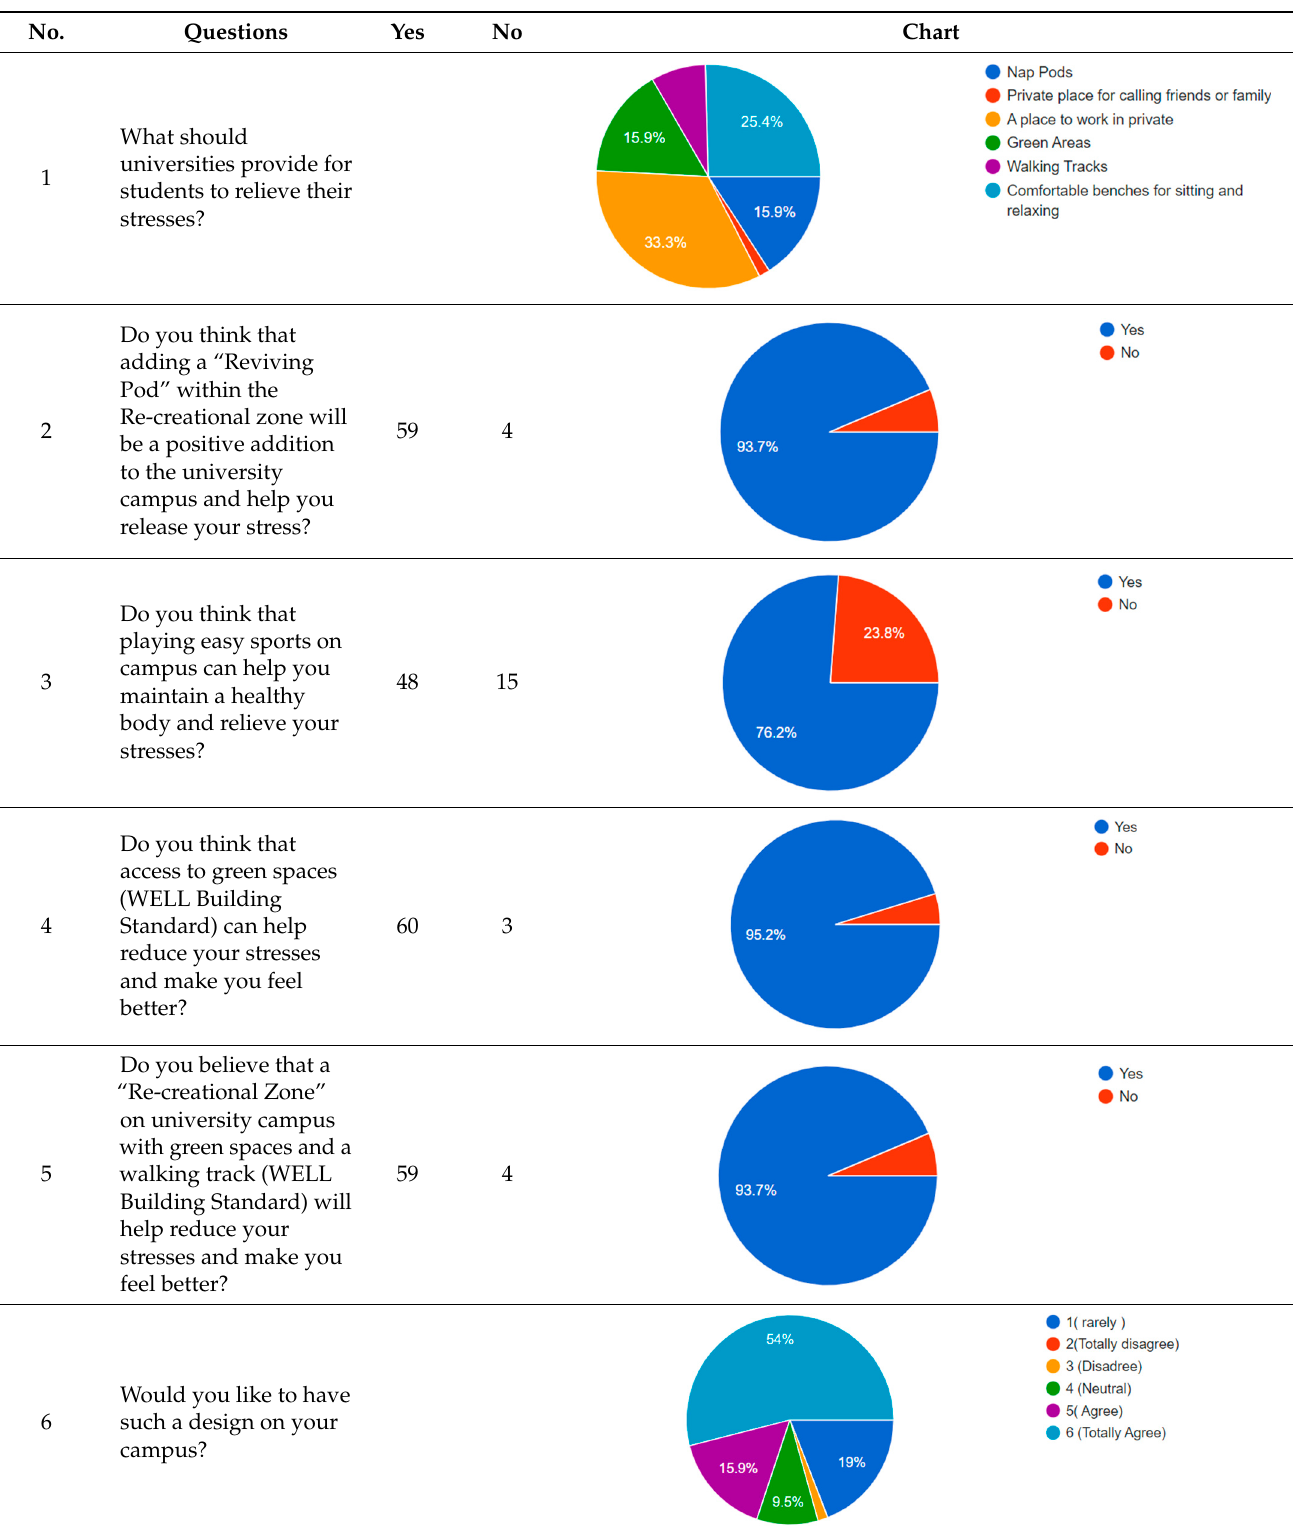
Table A2. Responses of 63 students at Dar Al Uloom University for (Section 2 of the survey: The “Re-creational Zone” with “REVIVING POD”), created by the authors.